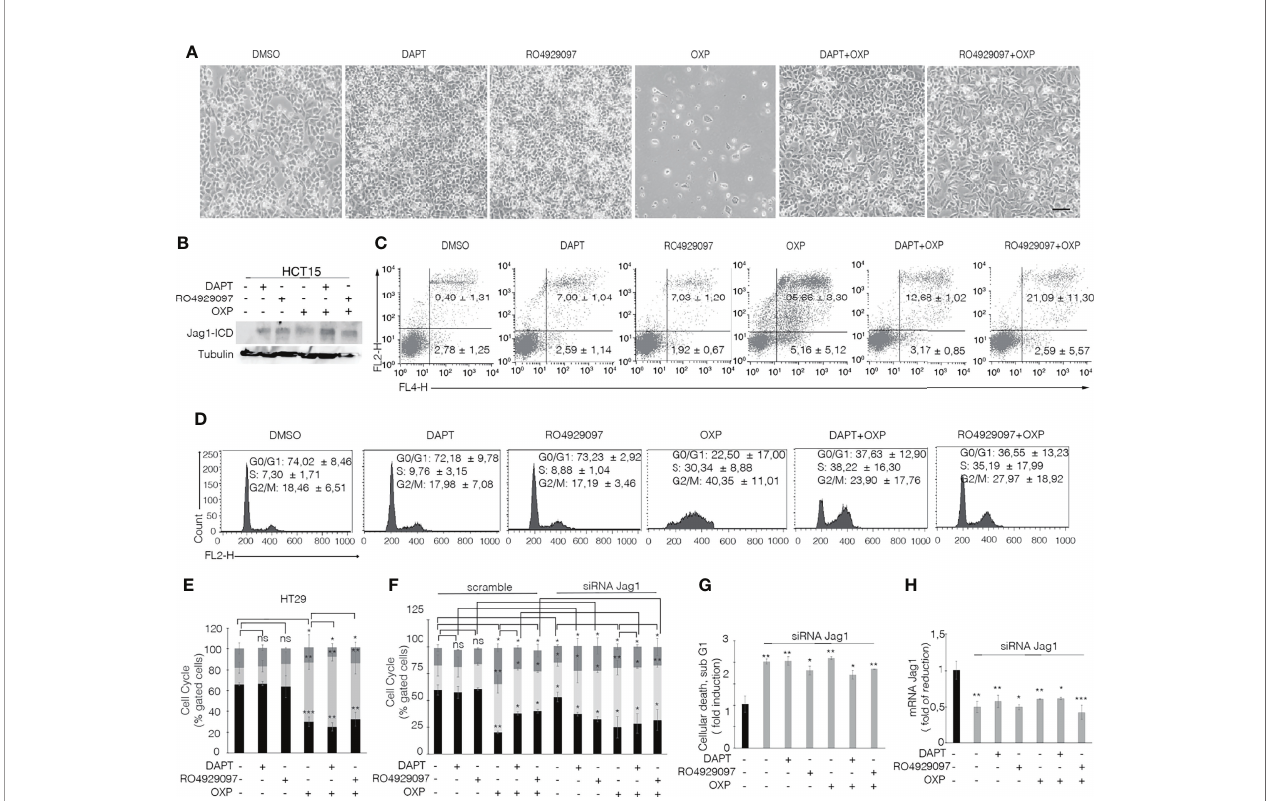
FIGURE 3 | GSIs operate as promoting agents in Jagged1/KRAS CRC cells and help cells escape from the OXP-induced cell cycle block in a Jag1-ICD-dependent manner. (A) Representative plate area of HCT15 cells treated with 10 pmol/ m l of DAPT, RO4929097, and OXP alone or in combination. Scale bar, 200 m m. (B) An amount of HCT-15 cells from panel A were collected and whole-cell extracts were immunoblotted or (C) stained against Annexin V (APC) with/without propidium iodide (PI) to evaluate the percentage of apoptotic cells and (D) cell cycle. (E) HT29 cells treated for 24 h with 10 pmol/ m l of DAPT, RO4929097, and OXP alone or in combination were stained with propidium iodide (PI) to analyze cell cycle progression. (F) Jagged1-silenced HCT15 cells (siRNA-Jagged1) or control siRNA (scramble) were treated for 24 h with 10 pmol/ m l DAPT, RO4929097, and OXP, alone or in combination, and stained with propidium iodide (PI) to analyze cell cycle progression and (G) subG1 cellular death. (H) Jag1 mRNA expression levels revealed by qRT-PCR assay in Jagged1-silenced HCT15 cells or scramble cells, from panel (F) Results are expressed as fold of reduction relative to control. Data were normalized with respect to GAPDH expression. All data are representative of at least three independent experiments, each in triplicate. ns, p > 0.5; * p < 0.05; ** p < 0.01; *** p < 0.001 (Student ’ s t